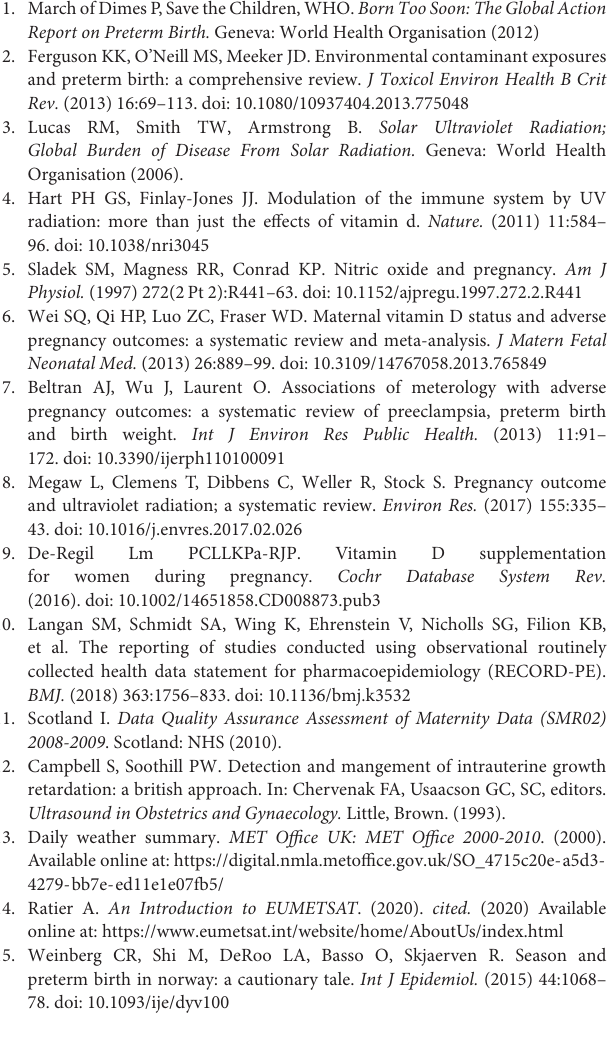
Supplementary Figure 1 | Directional Acyclic Graph for main model. DAG shows the role of potential confounders in the relationship between environmental sunlight availability and gestational length of pregnancy. Adjusted and unadjusted variables are represented by white and blue circles respectively. This model indicates an unbiased pathway from sun availability to the outcome.